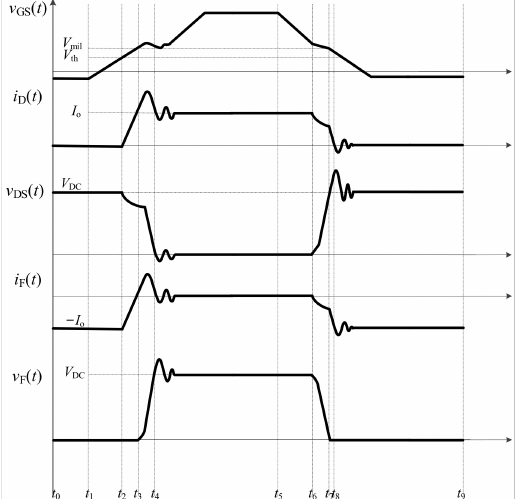
Figure 2. Switching waveforms during the turn-on and turn-off transitions of the SiC